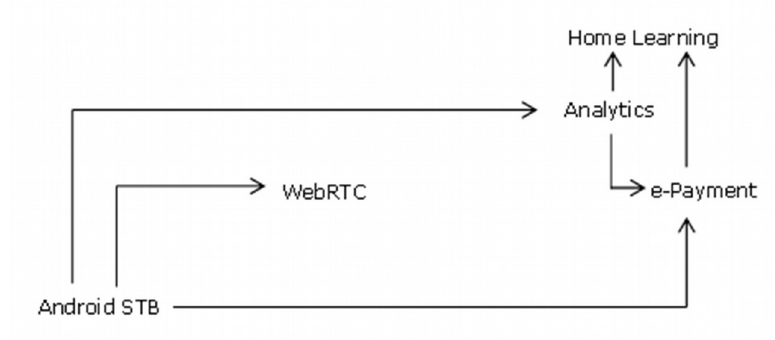
Figure 5. Sample 2 of Home Learning